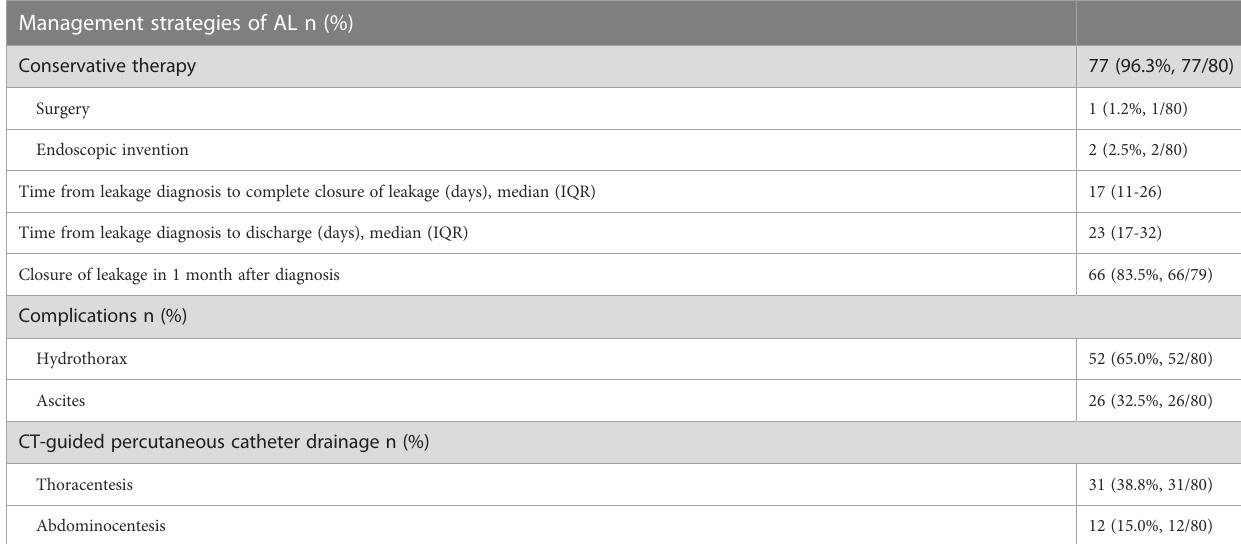
TABLE 6 Outcome of conservative therapy for anastomotic leakage. Management strategies of AL n